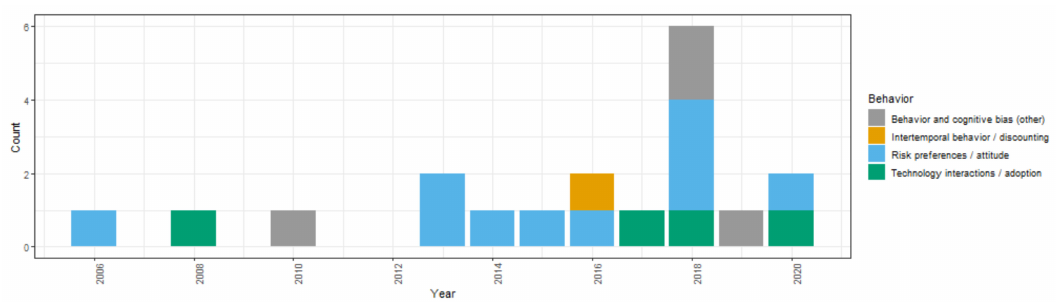
Figure A1. Frequency of social preference studies by type.